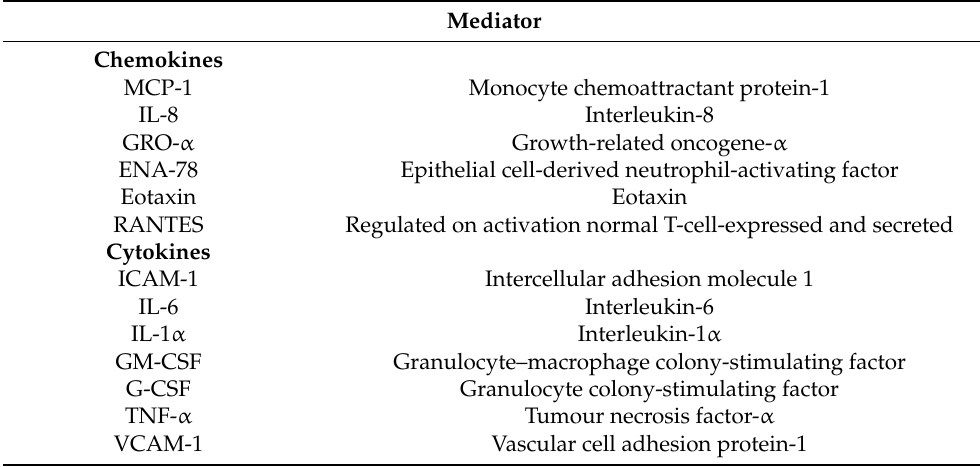
Table 1. Measured soluble factors in cutaneous wound